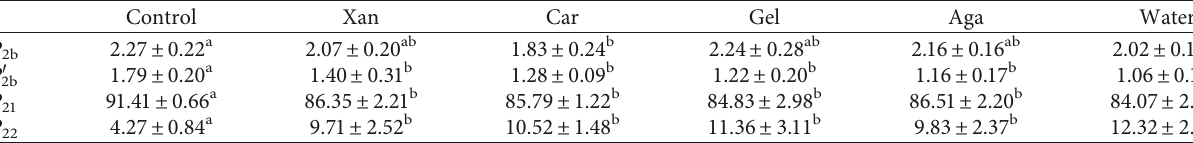
Table 5: Effects of different hydrocolloids in intramuscular injection on the proportion of peak area of water molecules in porcine meat. Control Xan Car